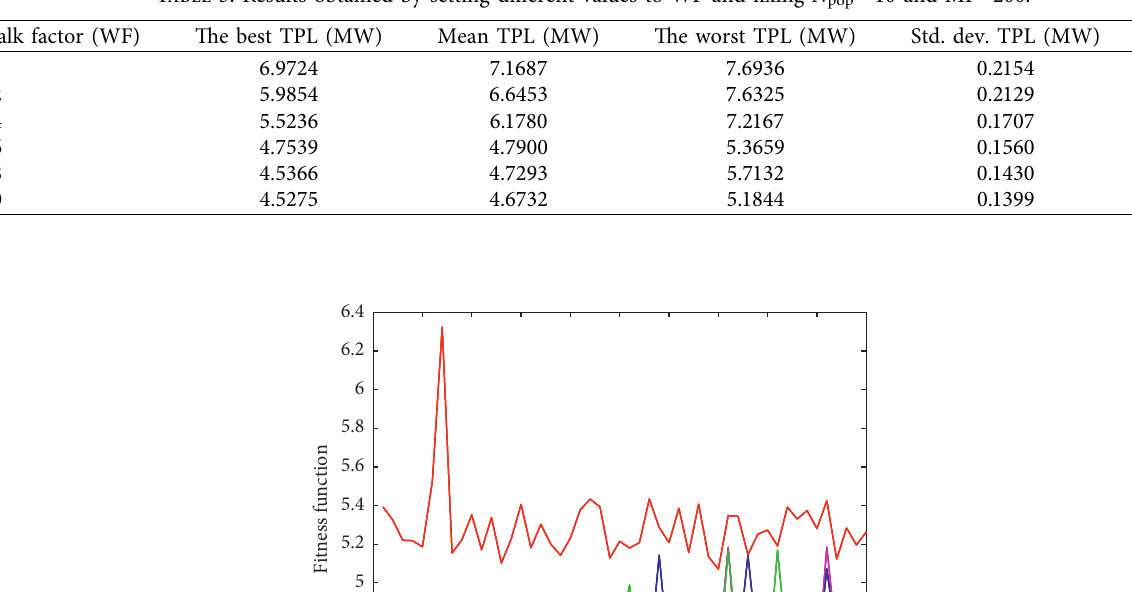
Table 2: Results obtained by setting different values to MI, and fixing N MI The best TPL (MW)